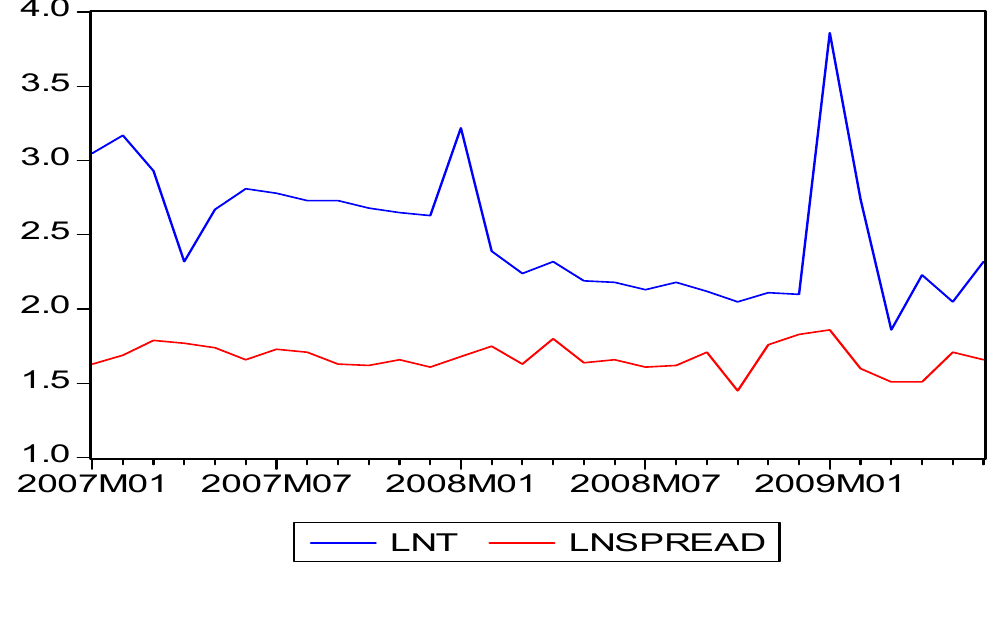
Figure-05: Non-Performing Financings, Burden and